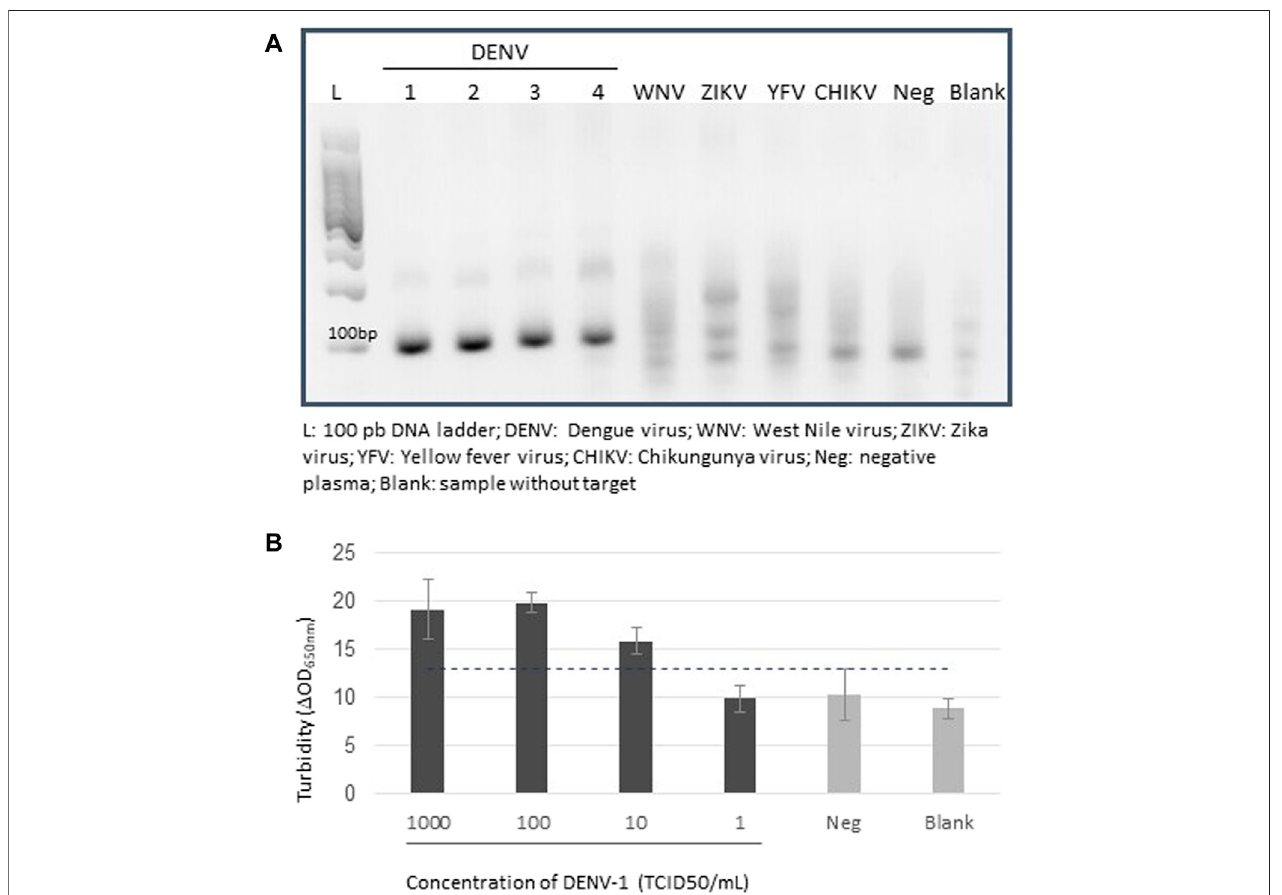
FIGURE2 | Detection ofampli fi ed DENVgenomes. (A) Electrophoresis ofRT-RPA – ampli fi ed products on a 2%agarose gel.The four serotypesofdengueviruses weretested (DENV-1 – 4).TheWestNilevirus(WNV),Zikavirus(ZIKV),chikungunyavirus(CHIKV),and yellowfevervirus(YFV)wereusedasspeci fi citycontrols.Negative plasma samples (Neg) were plasma samples from blood donors. No template control was de fi ned as a blank sample (Blank). (B) Detection of ampli fi ed DENV-1 genomes. Analysis took place on serial dilutions from 1,000 to 1 TCID 50 /ml of DENV + cell culture supernatants, each tested in three replicates. Negative plasma samples (Neg) were plasma samples from individuals who had donated blood. Following extraction and RT-RPA, DENV genomes were analyzed using MFEA readout. No template control was de fi ned as blank sample (Blank). Error bars show standard deviation of triplicate measurements.